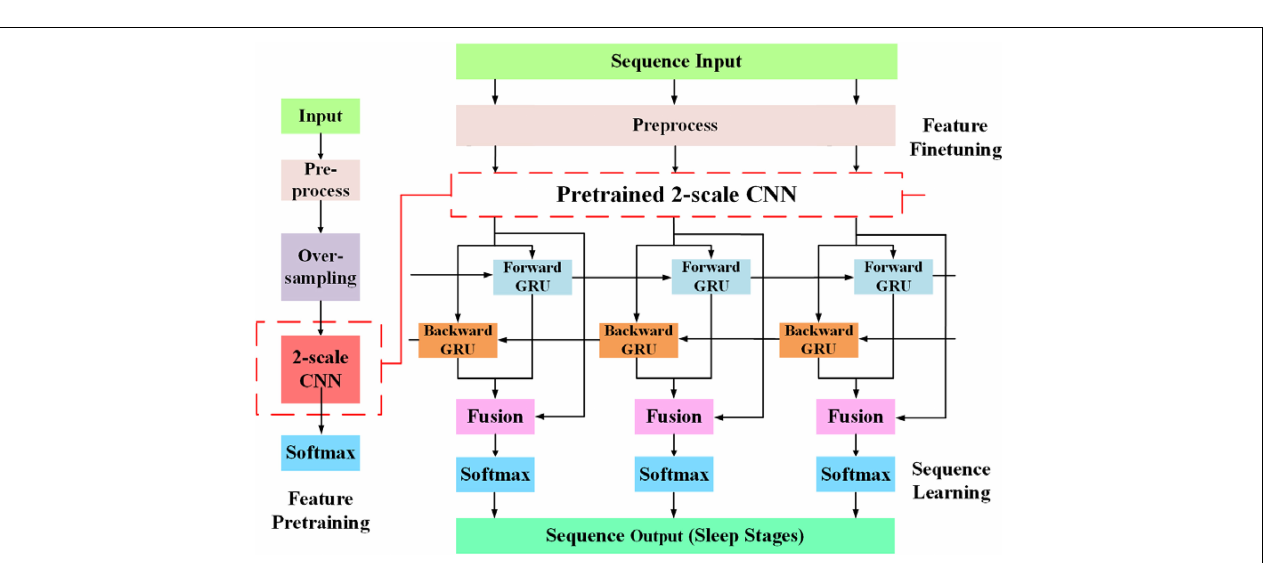
FIGURE 4 | The oversampling approach is based on data augmentation. An example of the morphological operation is shown in the upper part. The blue waveform is the original EOG signal, and the red waveform suffers one translation with a length of 15 s and adds white noise with an SNR of 10 dB.